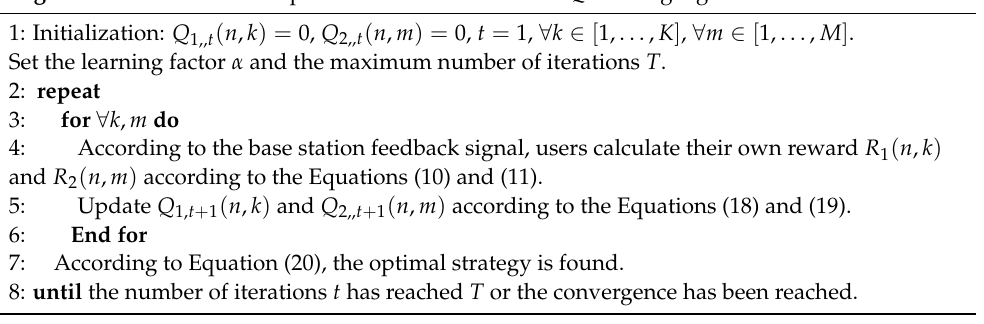
Algorithm 1 : The user n cooperative distributed double Q learning